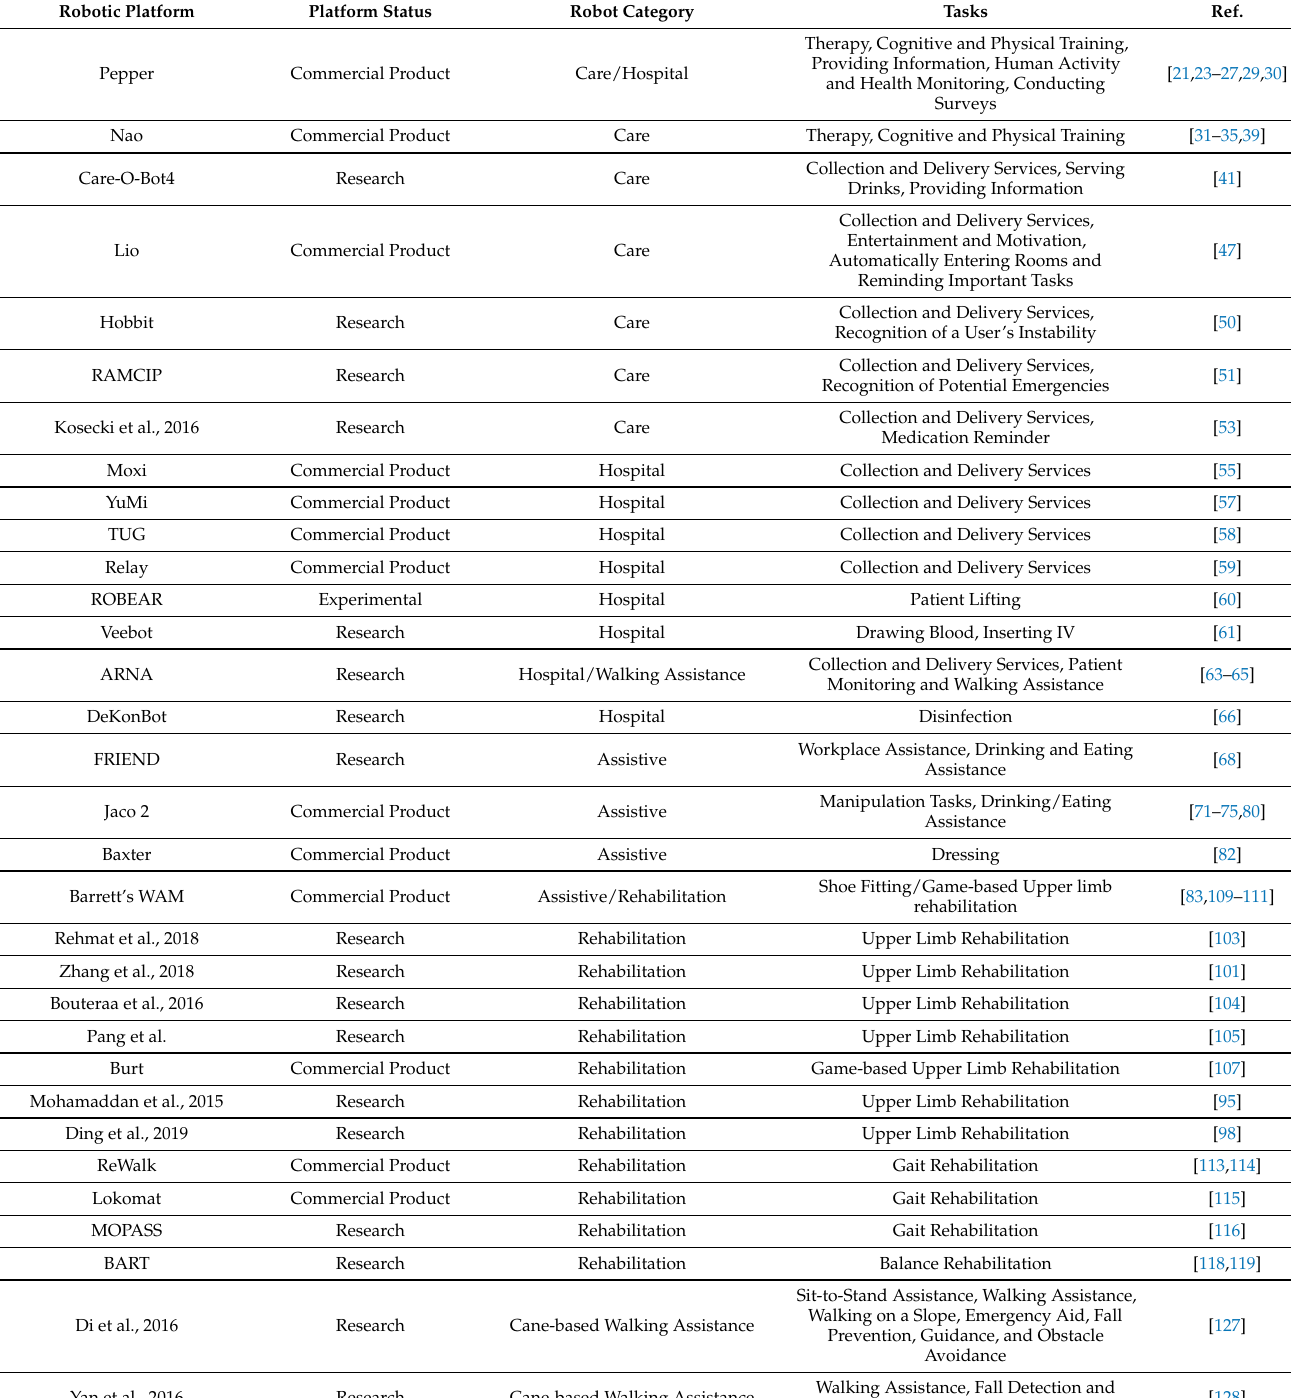
Table 1. Overview of the robotic platforms presented in this